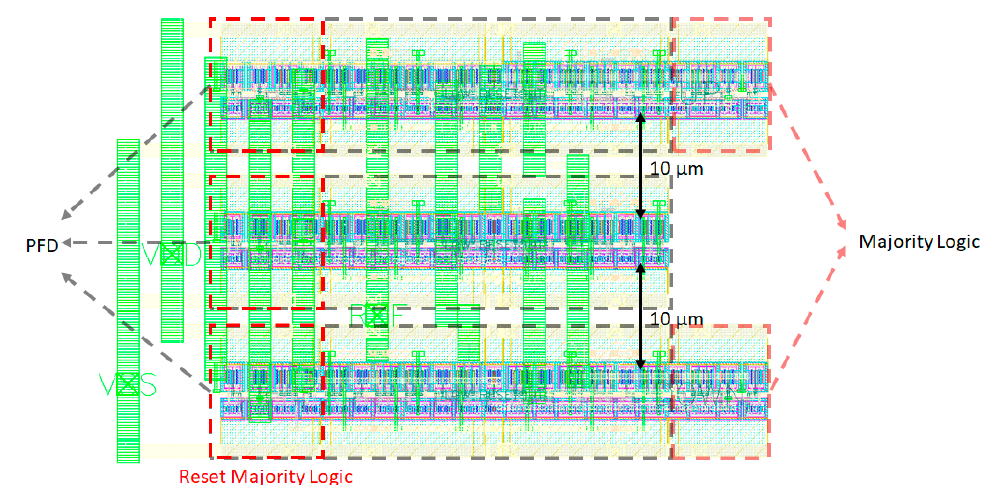
Figure 16. Phase/Frequency Detector’s layout. Figure 16. Phase / Frequency Detector’s